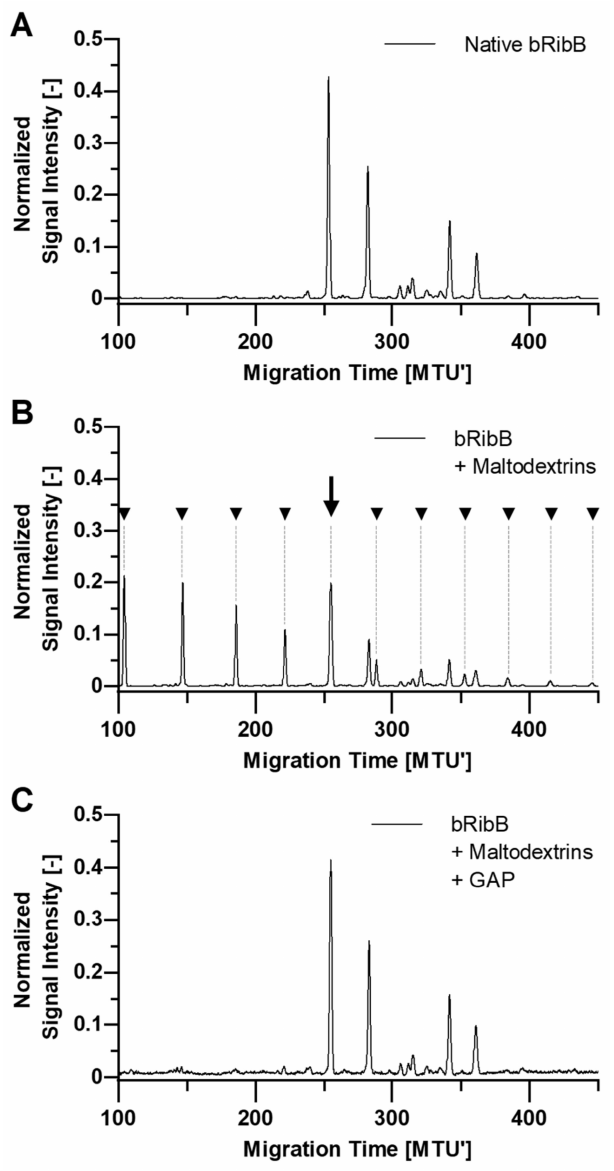
Figure 4. Glucoamylase P-supported degradation of spiked maltodextrins from a bovine ribonuclease B (bRibB) N -glycan sample. APTS-labeled N -glycans from bRibB ( A ) were spiked with APTS-labeled maltodextrins ( B ). Peaks of APTS-labeled maltodextrins are marked with black triangles. Treatment with glucoamylase P (GAP, 0.017 U/ µ L) for 30 min in disodium phosphate-citrate buffer at pH 5 restores the original N -glycan fingerprint ( C ). Success of maltodextrin spiking, and glucoside hydrolase treatment were controlled by xCGE-LIF. Migration time plotted on the x -axis was aligned to an internal migration time standard, resulting in Migration Time Units (MTU’). Signal intensity (peak height) of automatically picked peaks was normalized to a sum value of 1. Data analysis was performed using